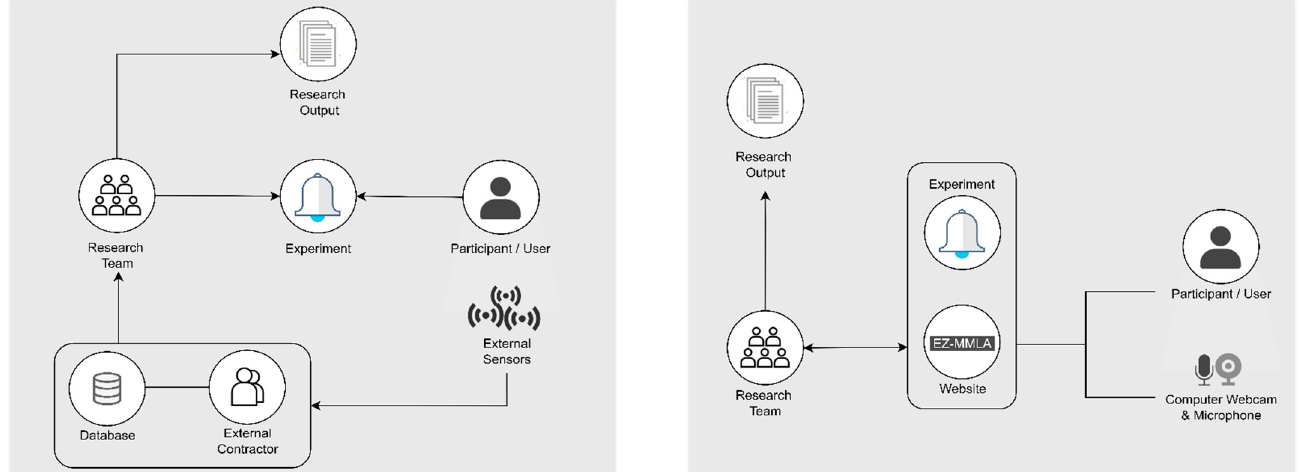
Figure 2. The image on the left represents a typical multimodal data collection process, involving physical sensors, proprietary software, or external contractors. The diagram on the right represents how data collection in the EZ-MMLA website is carried out locally with JavaScript models.